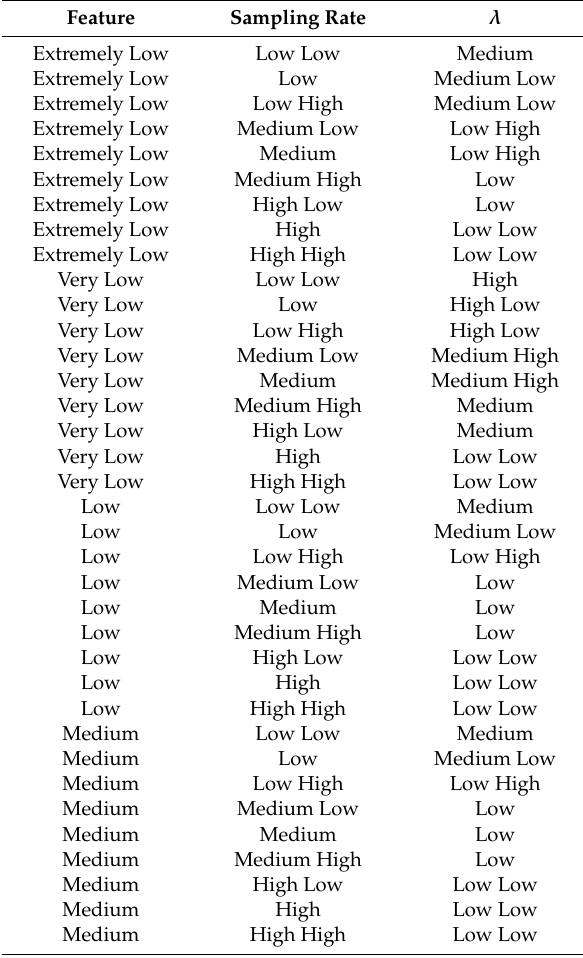
Table 4. Fuzzy rules for the fuzzy cost for λ .